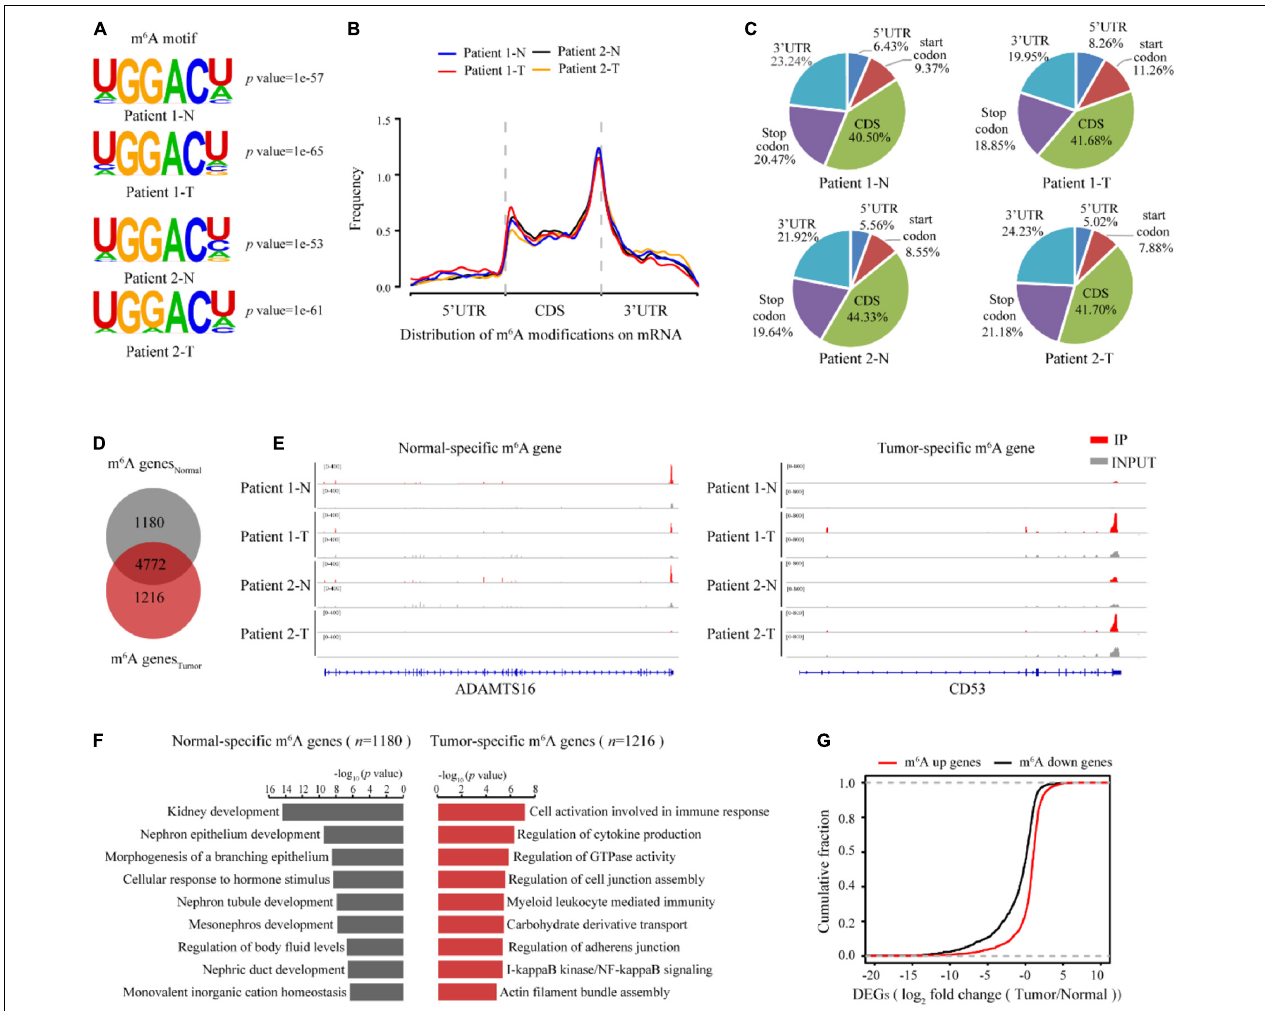
FIGURE 4 | m 6 A methylomes are profoundly reprogrammed during ccRCC tumorigenesis. (A) The consensus motif identified from m 6 A-seq peaks in the normal and ccRCC tissues. (B) The normalized distribution of m 6 A peaks generated from the normal and tumor tissues across the mRNAs. (C) Pie chart of m 6 A peak proportions in the indicated regions in the normal and tumor tissues. (D) Venn diagram of the m 6 A-modified genes detected in the normal and tumor tissues. (E) Profile of IP and input reads of representative normal-specific and tumor-specific m 6 A peaks in ADAMTS16 and CD53. Levels were normalized by the number of reads in the normal and tumor samples, and the values on the left side of the track represent the range of IP and input level. (F) GO pathway analysis of genes with normal-specific and tumor-specific m 6 A modification. (G) Cumulative distribution for the gene expression changes between the normal and tumor tissues for upregulated m 6 A methylation genes (red) and downregulated m 6 A methylation genes